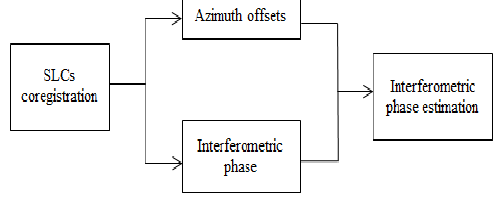
Figure 2. Overview of IPS processing flowchart